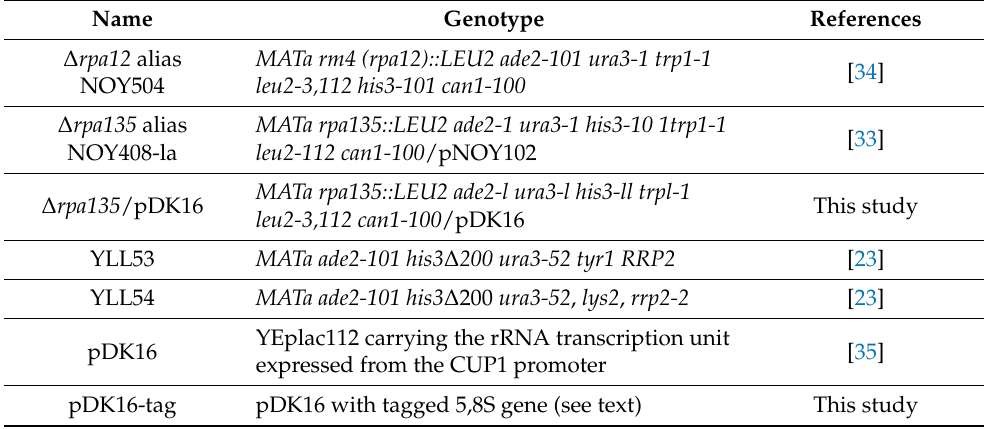
Table 2. Strains and